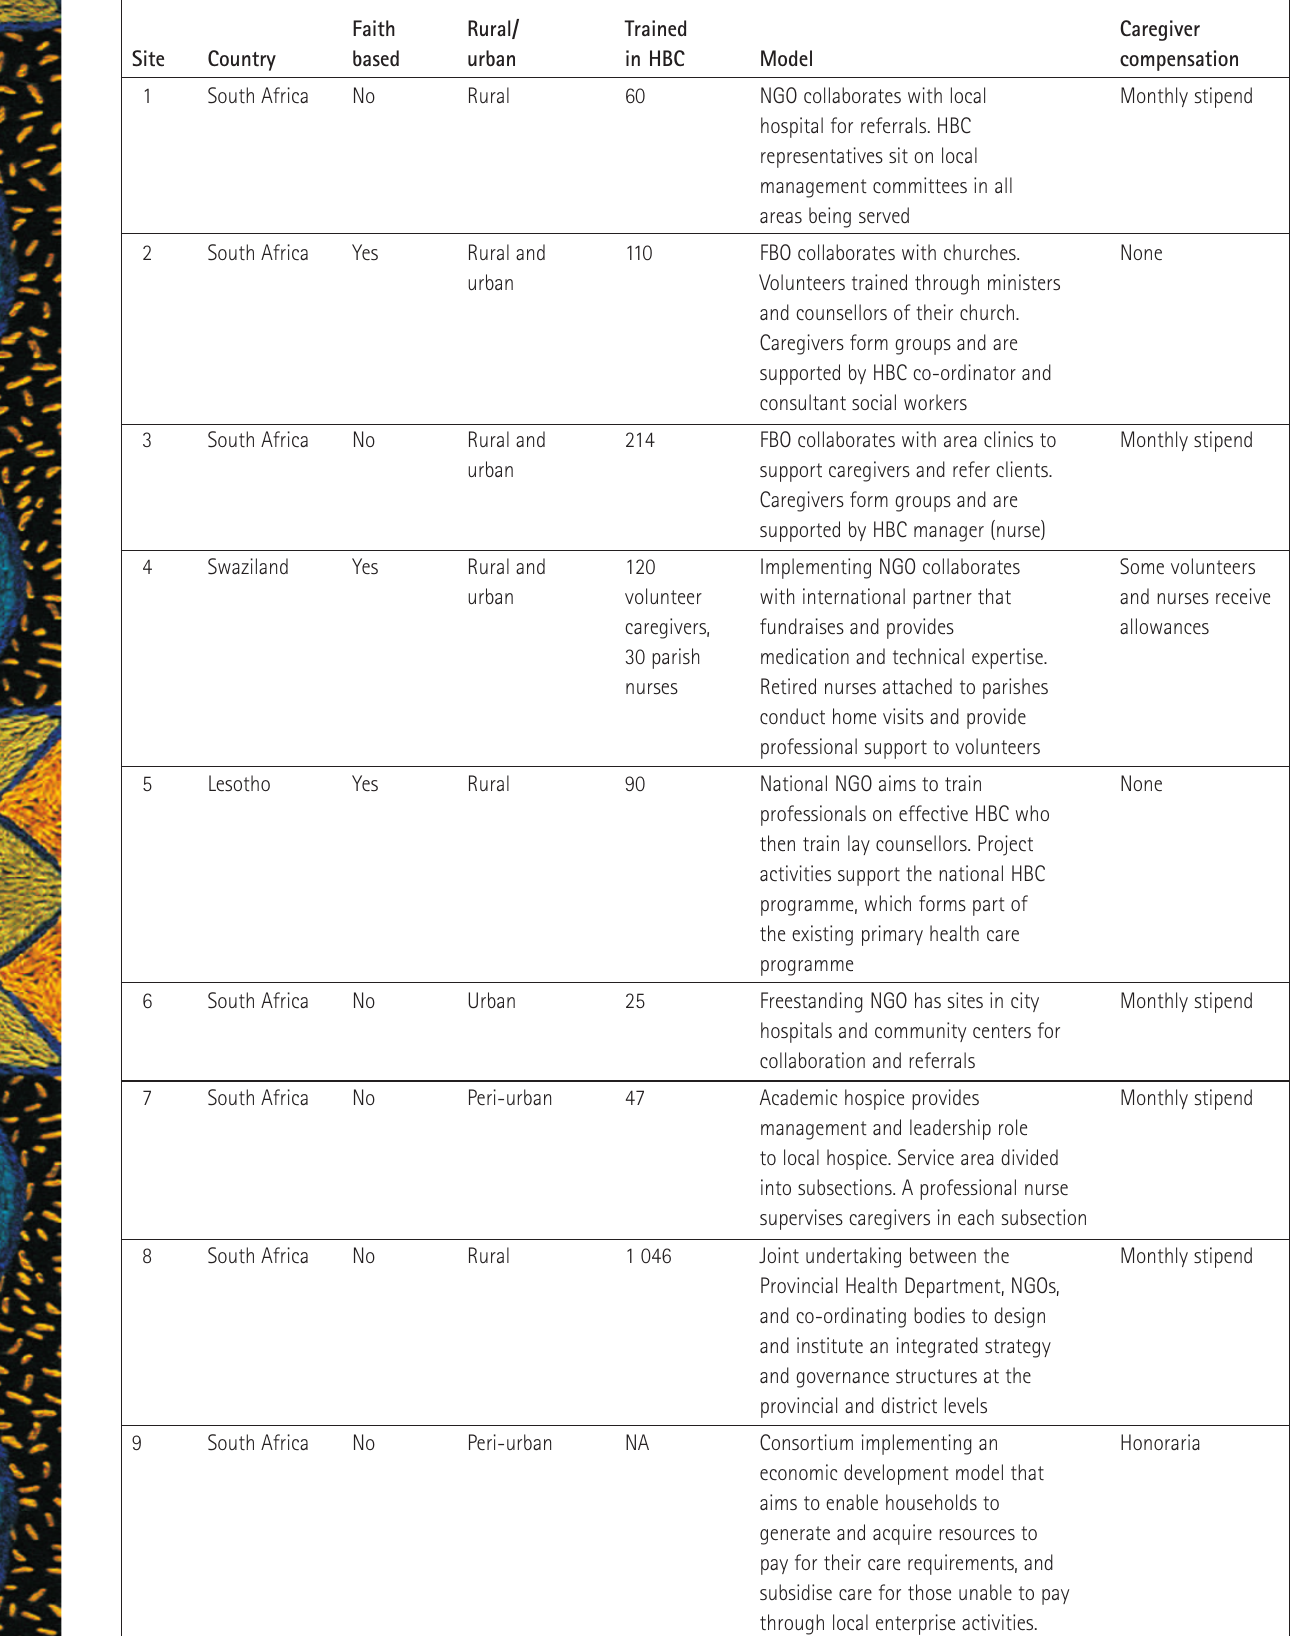
TABLE I. DESCRIPTION OF THE 9 HBC PROJECTS